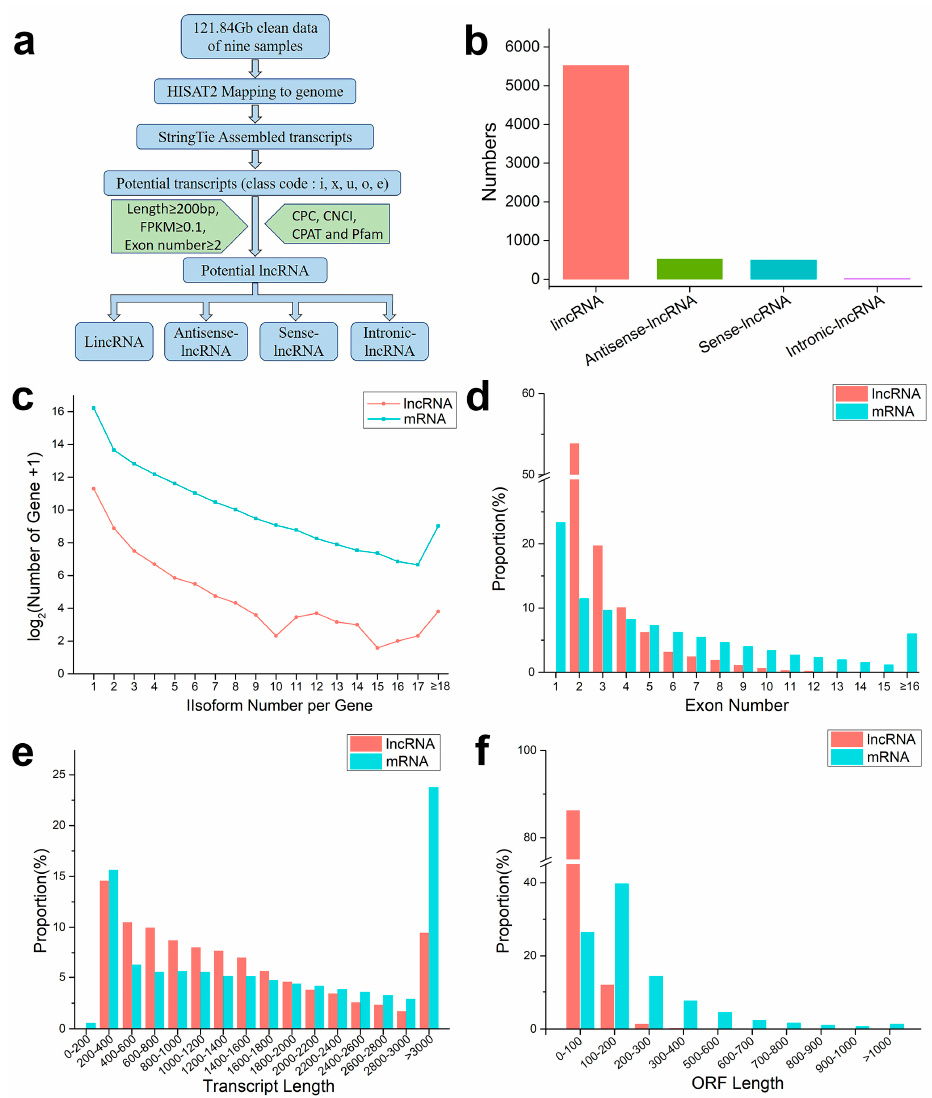
Figure 2. An integrative computational pipeline for the systematic identification and characterization of lncRNAs: ( a ) informatics pipeline for identification of lncRNAs; ( b ) composition of various types of lncRNAs; ( c ) number distributions of spliced lncRNAs and mRNAs; ( d ) proportion of exons per transcription for lncRNAs and mRNAs; ( e ) transcript length distributions for all lncRNAs and mRNAs; and ( f ) open reading frame (ORF) distributions for all lncRNAs and mRNAs. Table 1. Numbers of lncRNAs and mRNAs transferred in the soybean–dodder system. Mobility